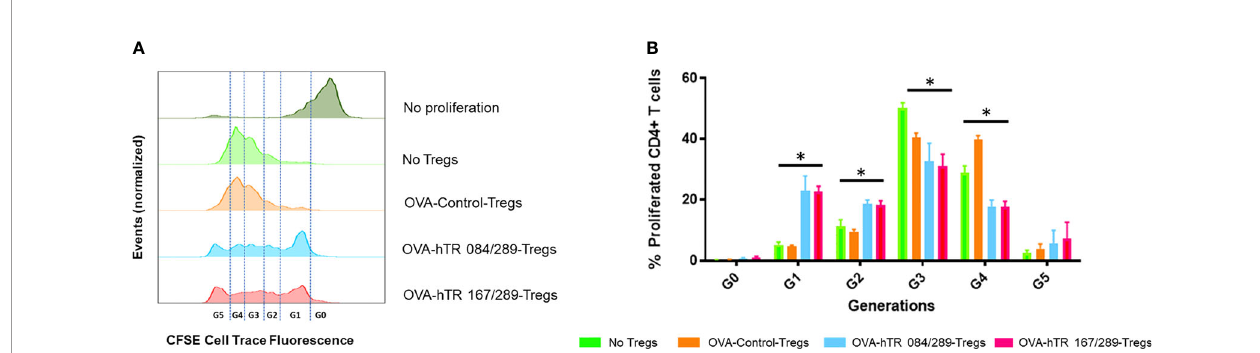
FIGURE 4 | Tregitopes induce highly suppressive Tregs in an in vitro bystander assay. An OVA-speci fi c co-culture system was established by co-culturing OVA- speci fi c OTII-CD4+ responder T cells, OVA-stimulated splenic DCs from OTII mice, and Tregs isolated from OVA-allergic mice treated with Control, hTR 084/289 or hTR 167/289. Proliferation was monitored by cell tracer staining and fl ow cytometry. (A) Representative histograms of cell tracer stained CD4+ proliferating cells and (B) frequency of CD4+ proliferating cells associated with generational distribution after 4 days of co-culture. *p, 0.05, one-way ANOVA